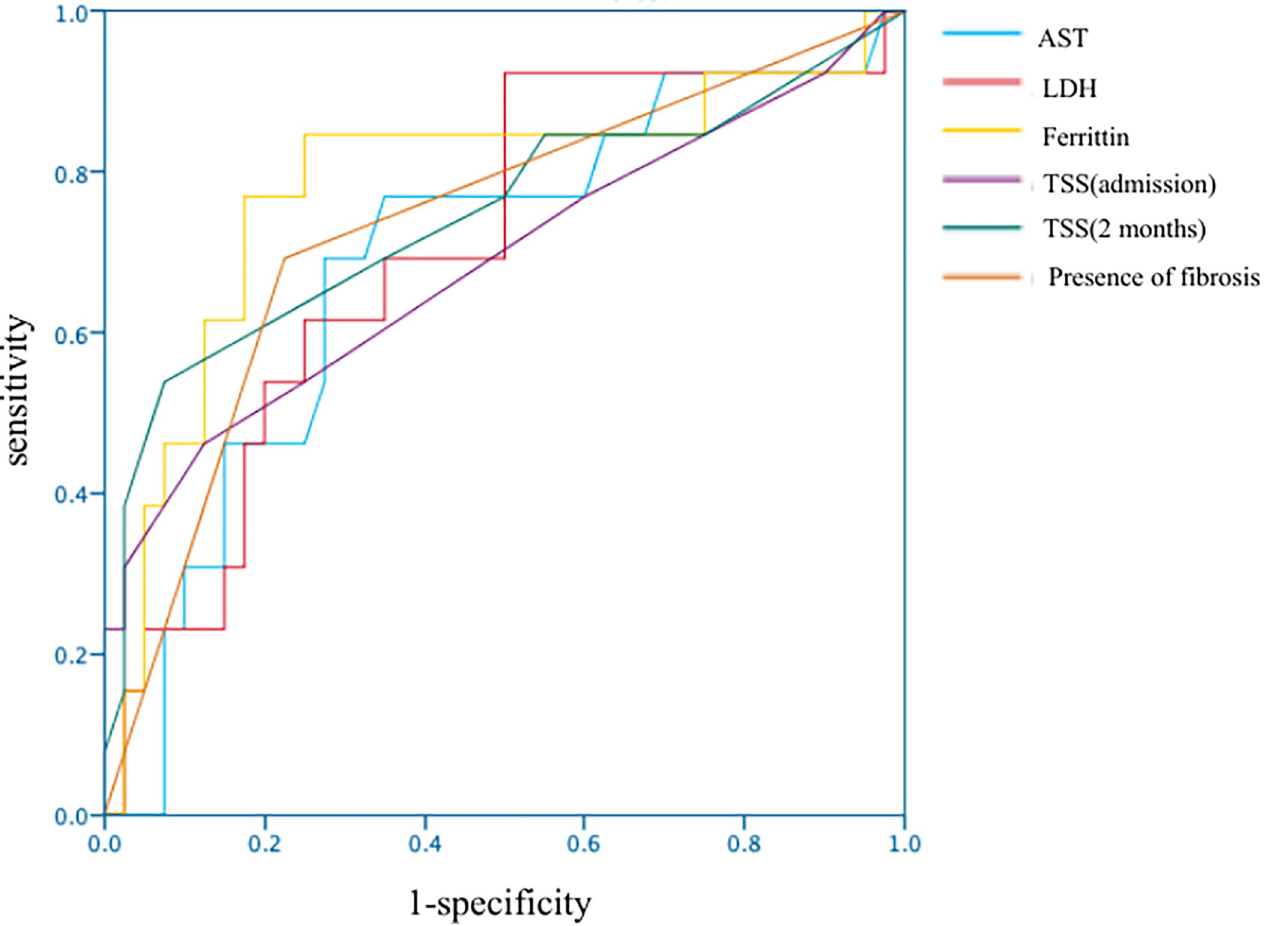
Fig 1. Receiver operating characteristic curves of clinical factors affecting DLCO impairment in the univariate analysis. Among the comparison factors, ferritin had the highest area under the curve. DLCO: diffusion capacity for carbon